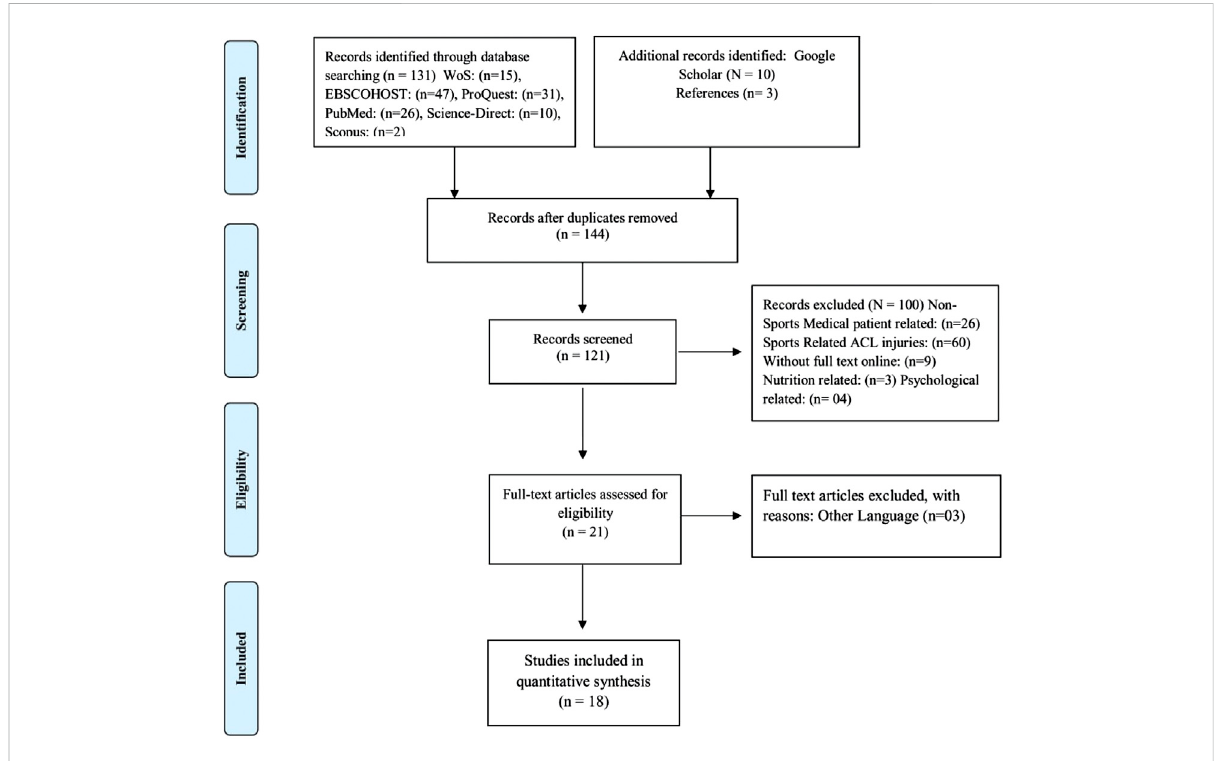
FIGURE 1 PRISMA fl ow chart of the study selection